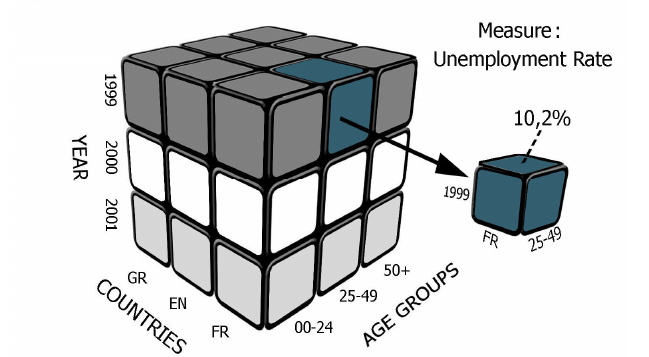
Figure 3: Example of Unemployment Data Organised in a Data Cube